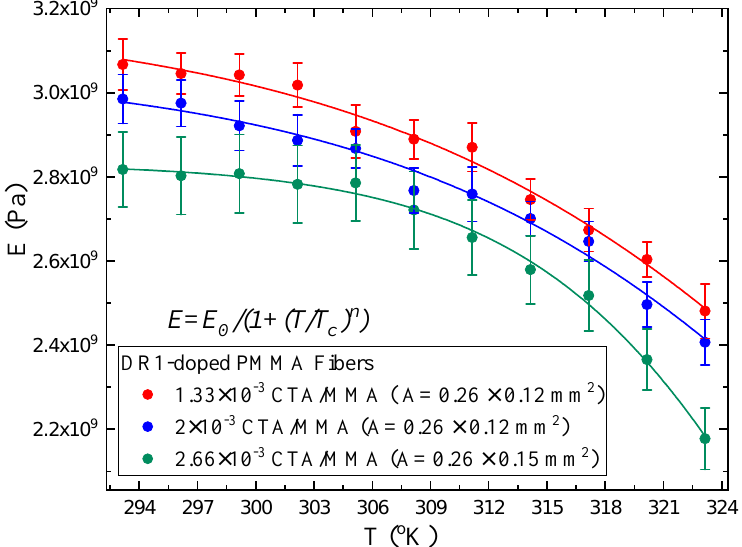
Figure 8. Measured Young’s modulus as a function of temperature for three CTA volume fractions (points with error bars) and fits to the model given by Equation (32).